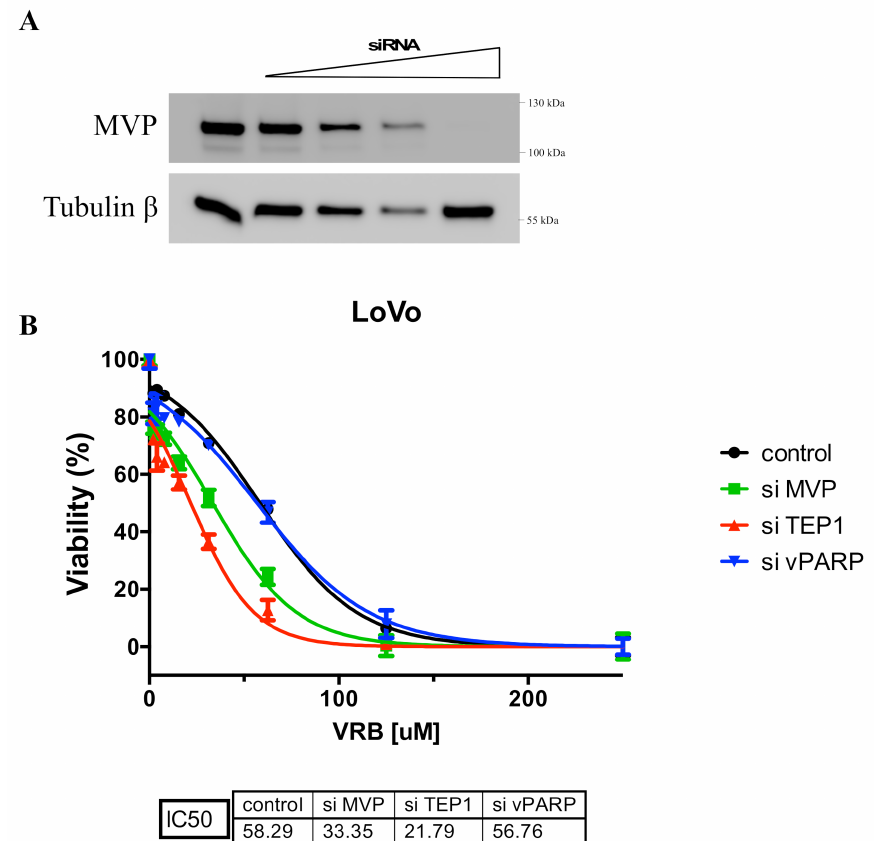
Figure 7. Viability determination for parental U2OS and transiently MVP-, TEP1- and vPARP- negative U2OS in the presence of vinorelbine (VRB). ( A ) Analysis of the effectiveness of MVP silencing by siRNA. ( B ) The survival curves of parental U2OS and transiently MVP-, TEP1- and vPARP-negative U2OS in the presence of vinorelbine